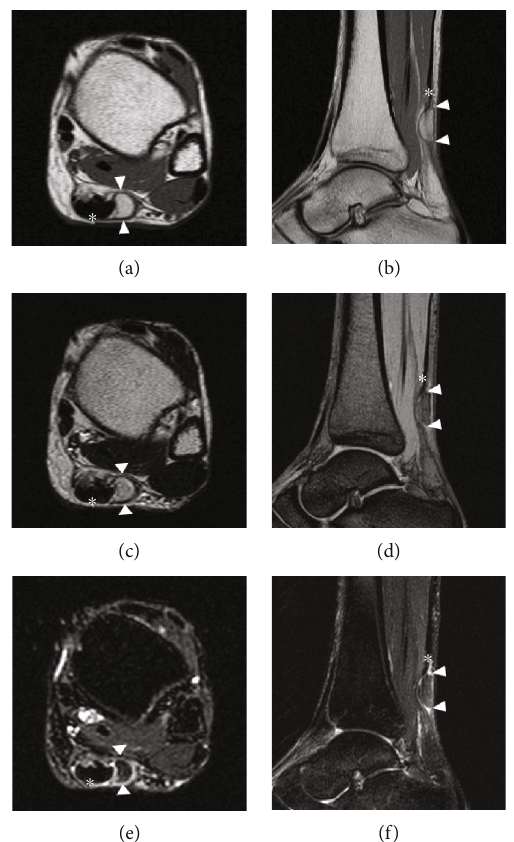
Figure 1: Magnetic resonance (MR) imaging at fi rst visit. Axial (a, c, and e) and sagittal (b, d, and f) T1-weighted (T1WI, a and b), T2- weighted (T2WI, c and d), and fat-suppressed T2-weighted (T2FS, e and f) MR images.Images show a lesion (arrowhead) at the lateral aspect of the Achilles tendon (asterisk). It is isointense relative to subcutaneous fat and is surrounded by a low signal intensity area, which allows it to be distinguished from adjacent adipose tissues. The continuity of the Achilles tendon was maintained, and no tendon injury was